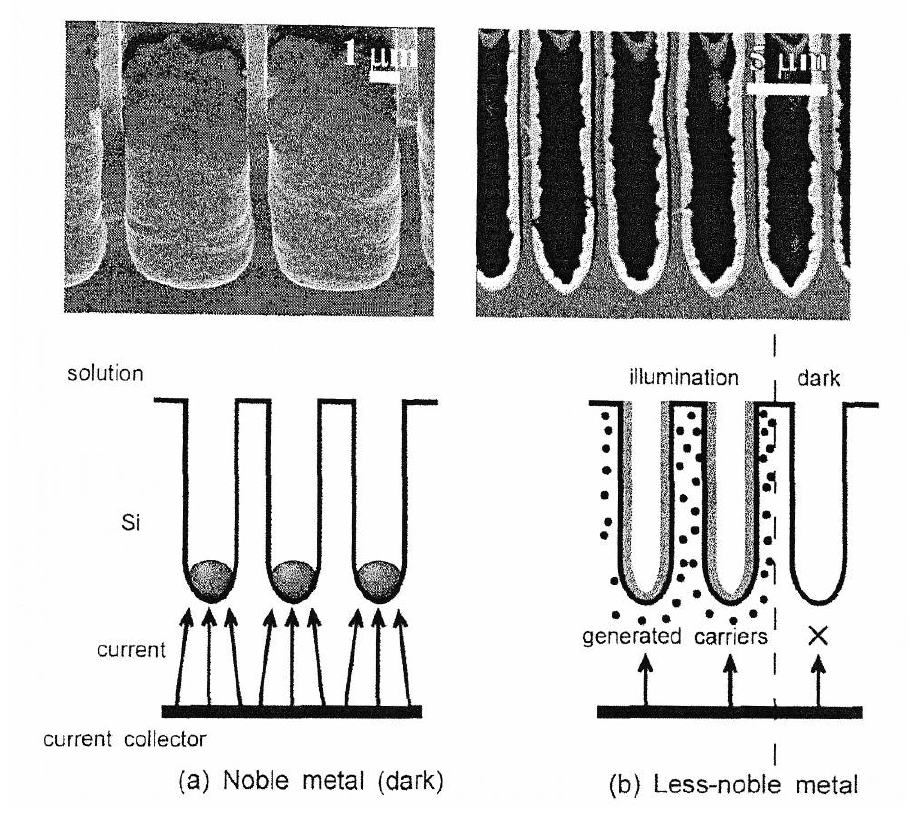
Figure 17. Scanning electron micrographs showing (a) the Cu-deposition within p-type macroporous silicon forming rods and (b) the deposition of Ni which covers the pore-walls. The image is taken from reference